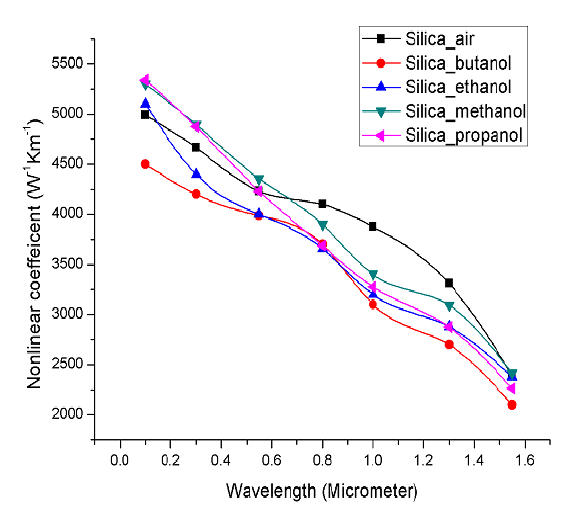
Figure 5: Nonlinear co efficient at different wavelengths Normalized frequency decides single mode propagation of any photonic crystal fibers. Normalized frequency, also termed as V effective maintains a significant value of lesser or equal to 4.1, to determine single mode property of a PCF.